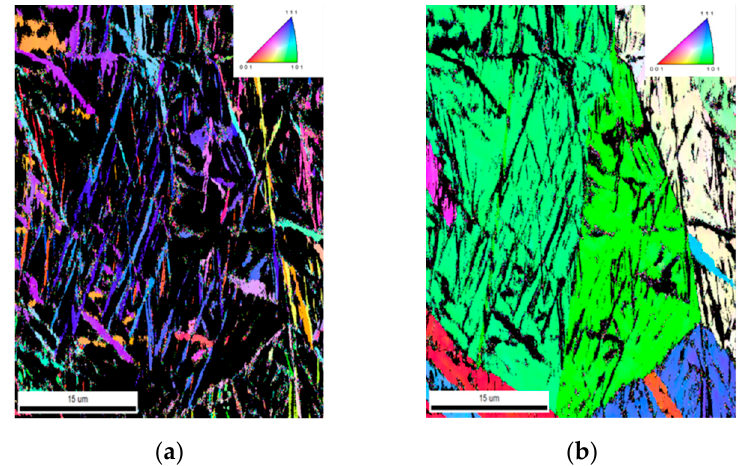
Figure 3. Electron backscatter diffraction ( EBSD) orientation maps of the structure formed at 220 °C for 22 h in a high-carbon (1.0 wt.%) and high-silicon (2.5 wt.%) steel: ( a ) indexed ferrite is shown; ( b ) indexed austenite is shown.